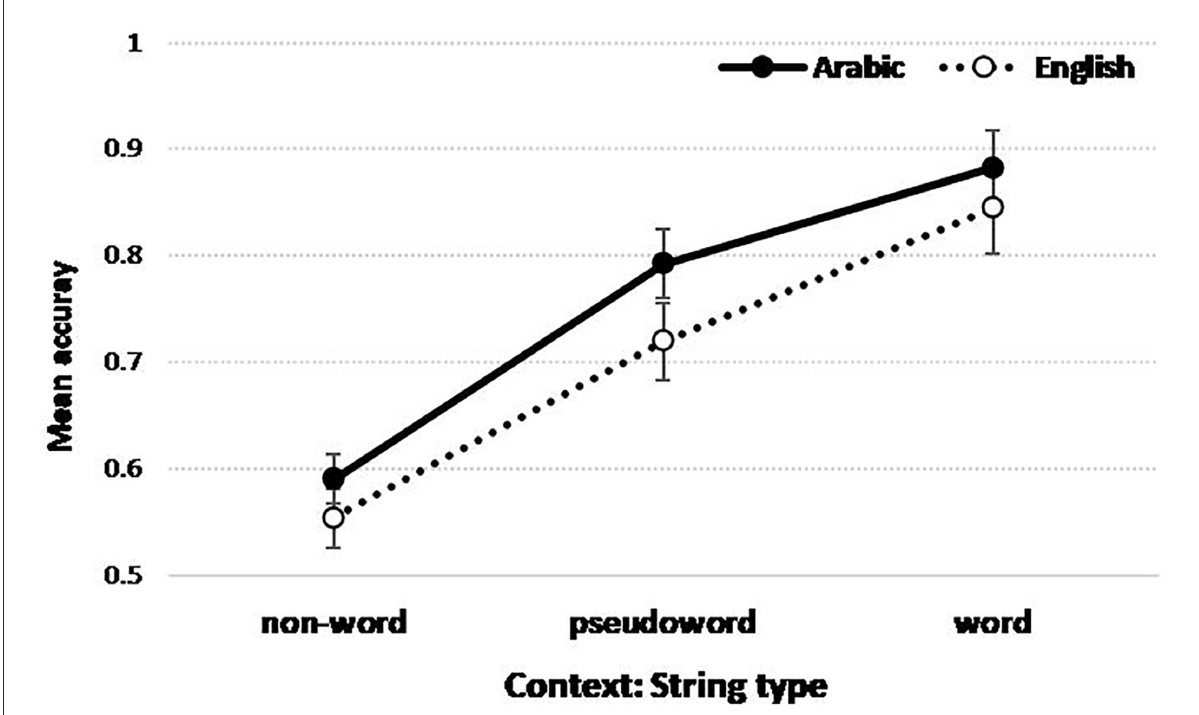
FIGURE4 Figure illustrating the interaction in accuracy scores (probabilities) between String type and Language. Mean with + /- standard